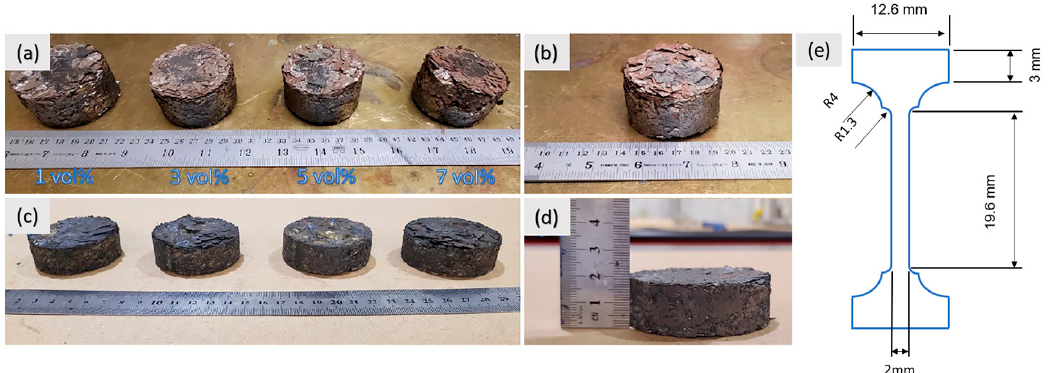
Figure 3. Appearances of chips Ti-6Al-4V matrix composite samples ( a ) 250 °C warm-compacted green compacts; ( b ) a single compact after warm compaction; ( c ) hot-pressed billets; ( d ) a single hot-pressed billet; and ( e ) a dog-bone-shaped specimen.